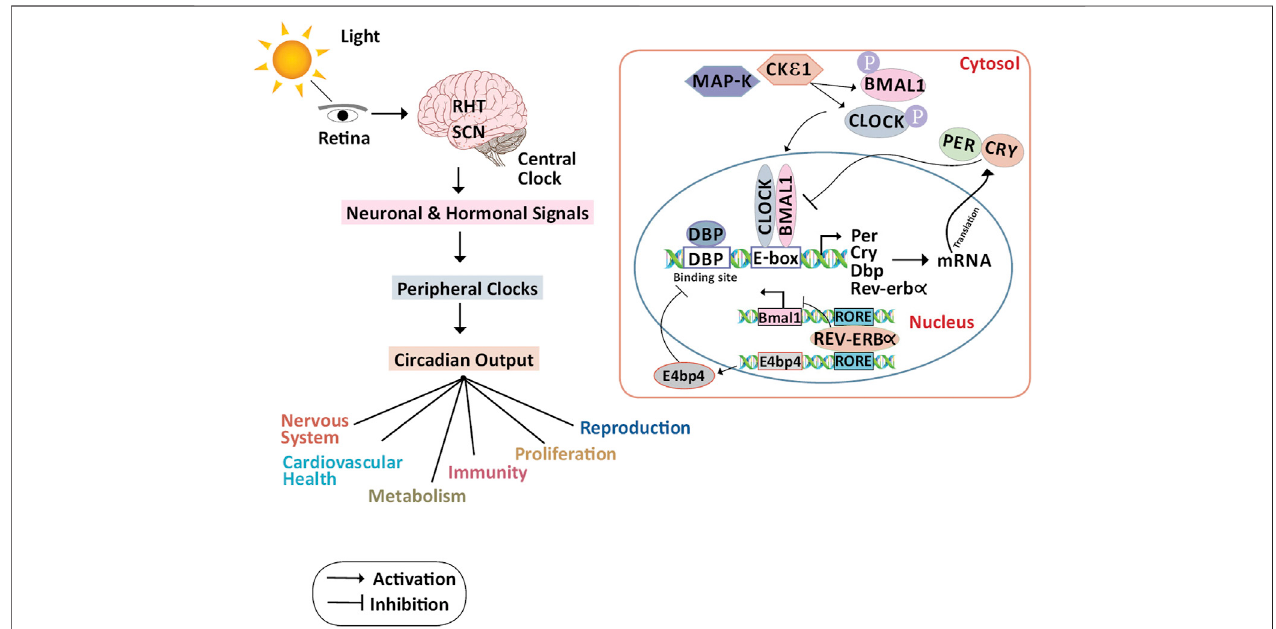
FIGURE 1 | Molecular mechanism of the circadian clock and its physiological regulations: In the primary TTFL, as light strikes the retina, the impulses are routed by RHTintheSCN.ThesignalsfromthecentralclocksproducedbySCNaretransmittedtotheperipheralorgansashormonalandneuronalsignals,andascircadianoutputs, severalphysiological functionsarecontrolled.Inthecytoplasm, CKI ε and MAPKphosphorylateCLOCKand BMAL1. InthenucleusCLOCK/BMAL1heterodimerbindsto the Per, Cry, and other circadian genes through the E-box element present on the DNA and activates the transcription of these genes. PER and CRY proteins translocatetothecytoplasmandrepresstheirtranscriptionbyinteractingwithCLOCK/BMAL1heterodimer.DBPproteinbindstotheDBPbindingsiteofthePer,Cry,and othercircadian genesthusactivatingthetranscription.ThesecondaryTTFL isprimarilyregulatedbytranscriptionalactivationoftheRORsand suppression ofREV-ERB α . REV-ERB α bindstotheRORelementsintheBMAL1promoter,suppressingBMAL1transcription,toguidetherhythmicoscillationofBMAL1.RORaandRORbwhichbind totheRORE,ontheotherhand,activateBMAL1expression.E4bp4activatedbyREV-ERB α repressestheDBP.Abbreviations:BMAL1, BoneMuscleArnt-likeprotein 1; CLOCK, Circadian Locomotor Output Cycles Kaput; CKI ε , Casein Kinase ε ; CRY, Cryptochrome; DBP, D-Box binding protein; E4bp4, E4 Binding Protein 4; MAPK, Mitogen-Activated Protein Kinase; PER, Period; REV-ERB α /NR1D1, Nuclear receptor subfamily 1, group D, member 1; RHT, Retinohypothalamic Tract; ROR, Retinoic acid receptor-related Orphan Receptor; RRE, ROR Responding Element; SCN, Suprachiasmatic Nucleus; TTFL, Transcription/Translational Feedback Loop.